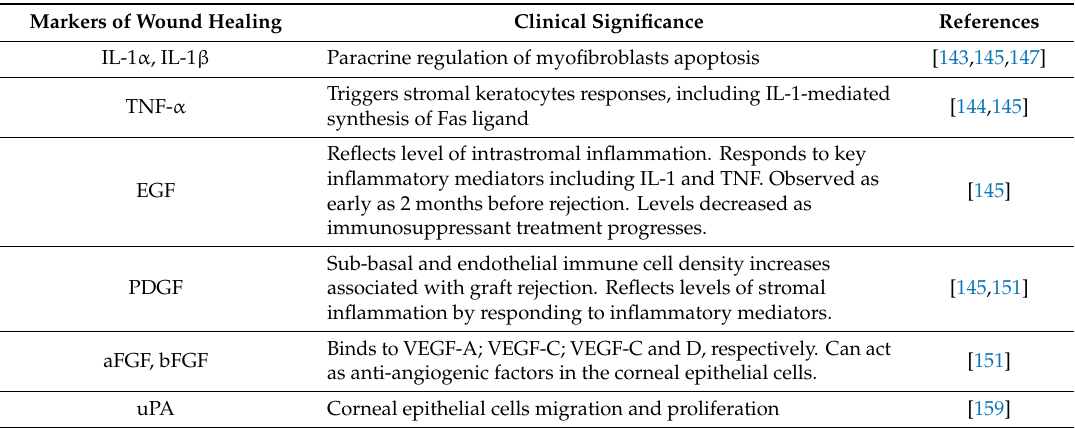
Table 5. Markers of wound